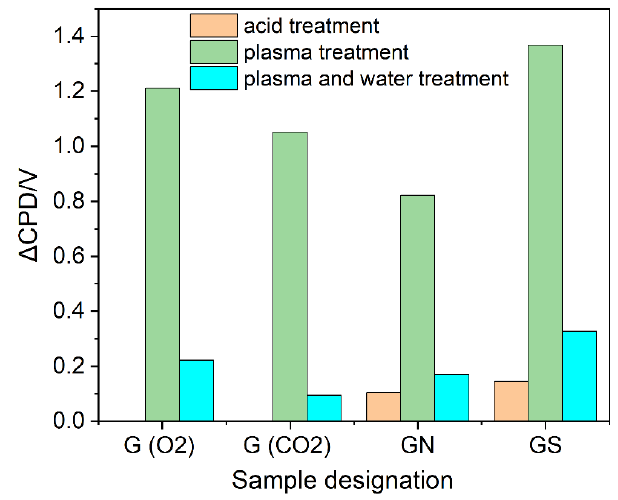
Figure 9. Changes in contact potential difference (changes in work function) of graphite samples—a comparison of acid and plasma treatments. G(O2)—oxygen plasma-treated sample, G(CO2)—CO 2 plasma-treated sample, GN, GS—nitric acid and sulfuric acid-washed samples later treated with oxygen plasma. Quantification of oxygen functional groups in graphite samples is shown in Figure 10. The oxygen content (based on Table S1) in the O 2 and CO 2 plasma and water ‐ treated samples is higher than in the original graphite, which explains the increase in work function. Interest ‐ ingly, CO 2 plasma is more effective in introducing OFGs, but water treatment leads to their decrease. In contrast, oxygen plasma appears to also activate the materials, similarly to the effect reported for graphene paper [25].